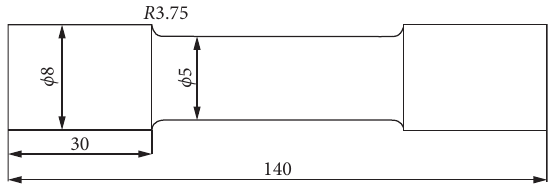
Figure 1: Schematic diagram of tensile